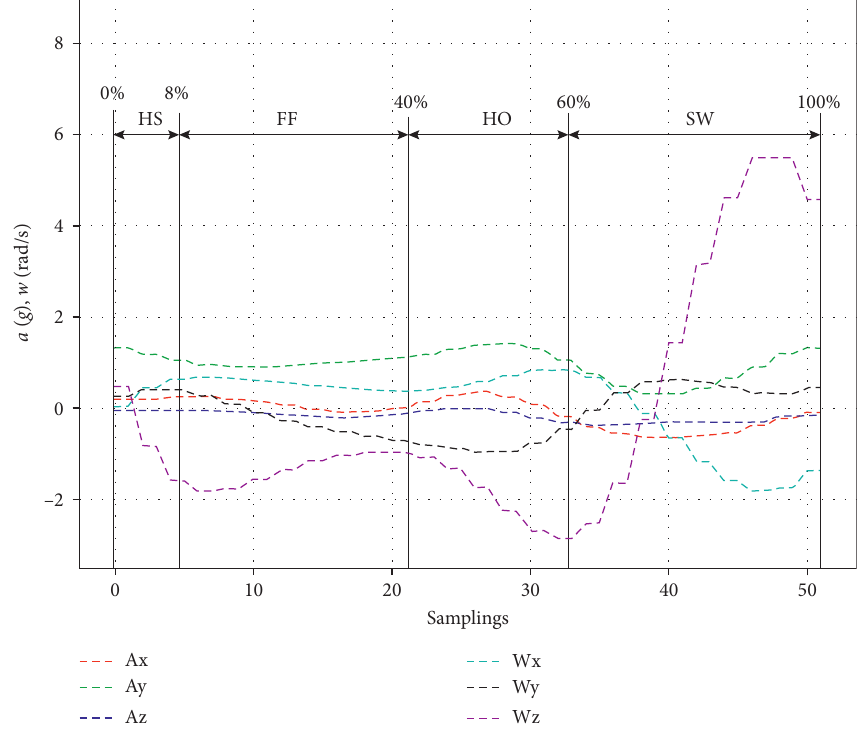
Figure 5: Phase division diagram of gait.